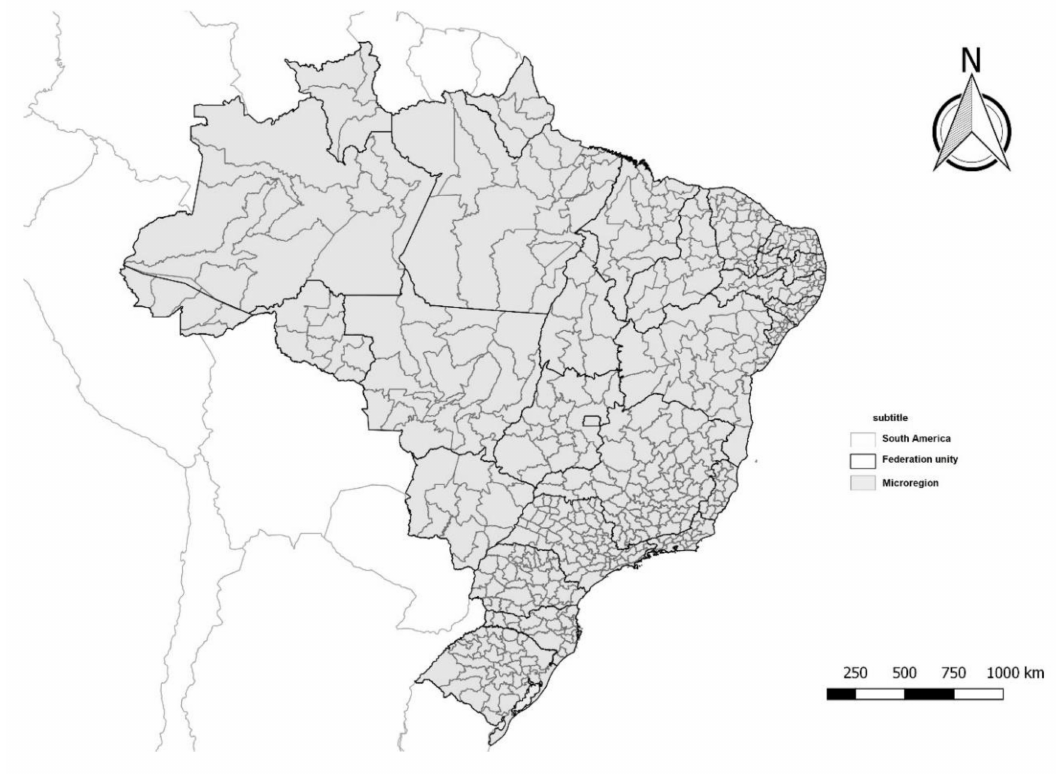
Figure 1. Study area: Brazil subdivided by